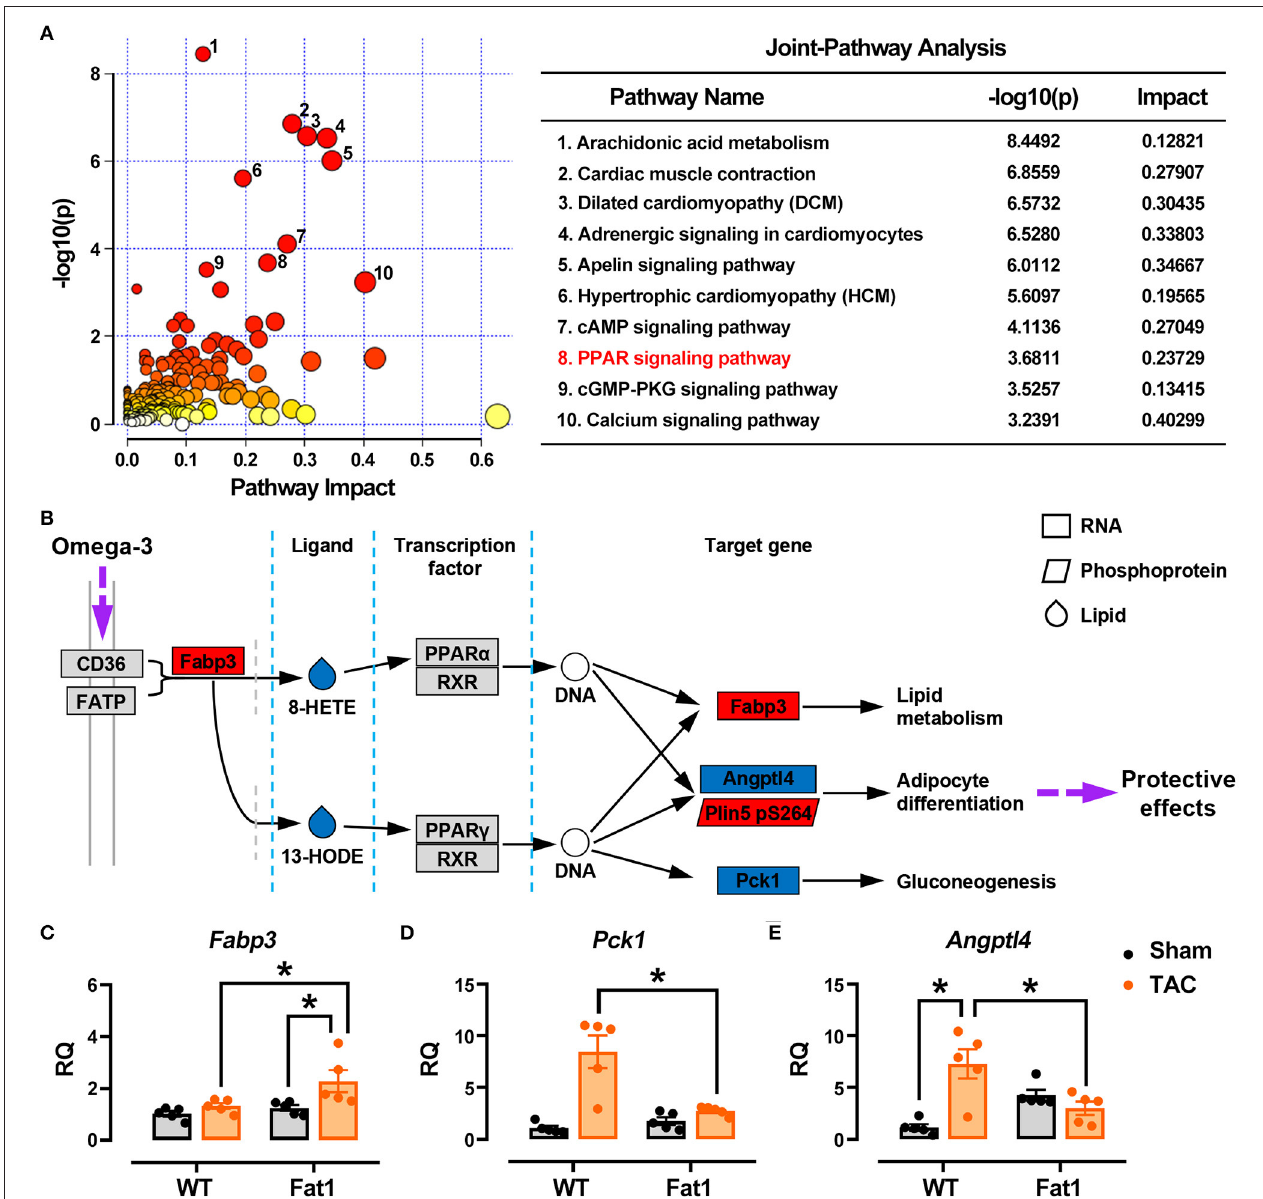
FIGURE 7 | Multi-omics data analysis. The results of RNA-sequencing, phosphoprotein quantification, and oxylipin profiling were integrated and analyzed (A) . Top 10 pathways affected by endogenous n-3 PUFAs were selected for analysis, and KEGG pathway analysis was applied to illustrate protective mechanism of n-3 PUFAs in pressure overload hearts (B) . Expression of genes identified from multi-omics data analysis has been determined by RT-qPCR (C–E) . * P < 0.05 between